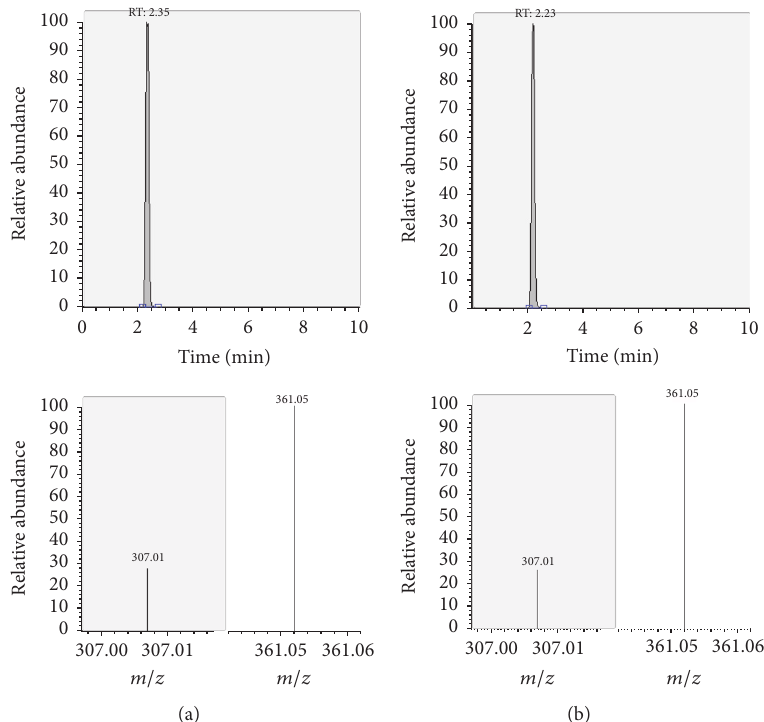
Figure5:LC-MS/MSchromatogramsofDEXandSRMtransitionsandrelativeabundances.(a)Standardina100 𝜇 gL −1 solution.(b)Standard in the spiked sample at 100 mgkg −1